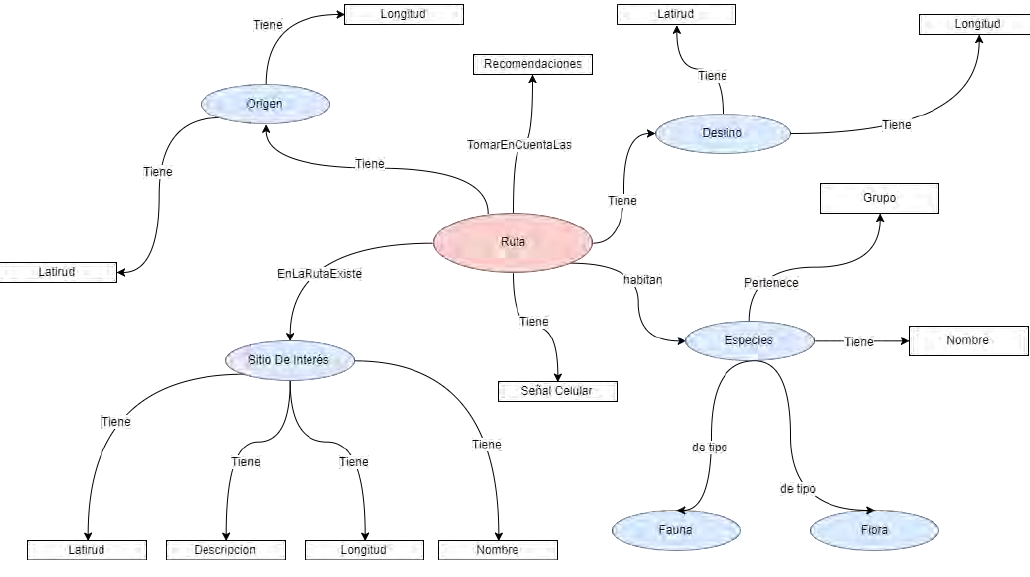
Figure 1 Conceptual model on work